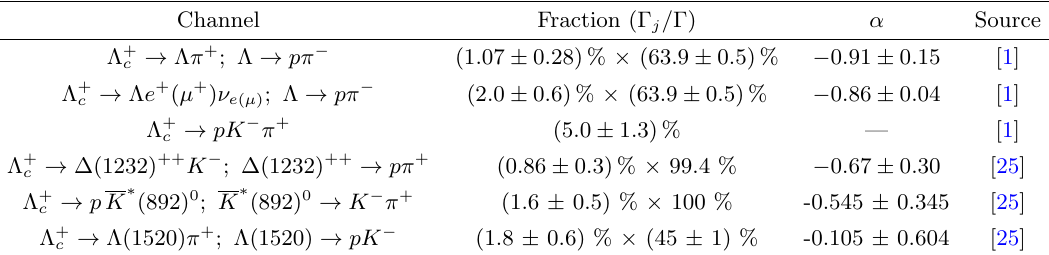
Table 1 . Branching fractions and weak-decay parameters (cid:11) for di(cid:11)erent decay modes of (cid:3) +